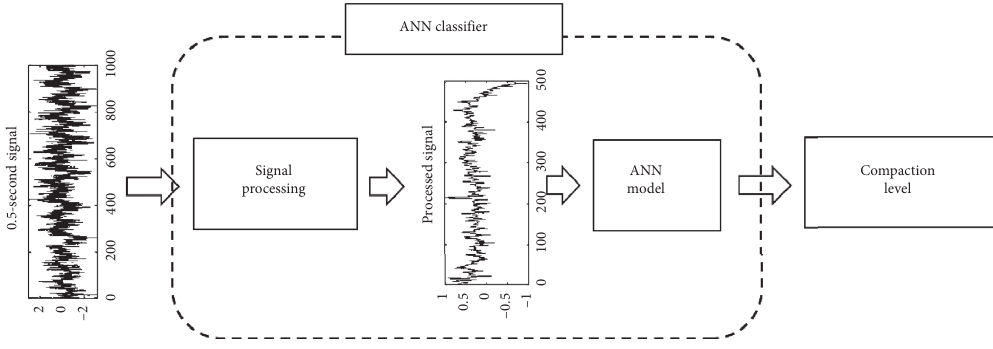
Figure 8: The ANN classifier.